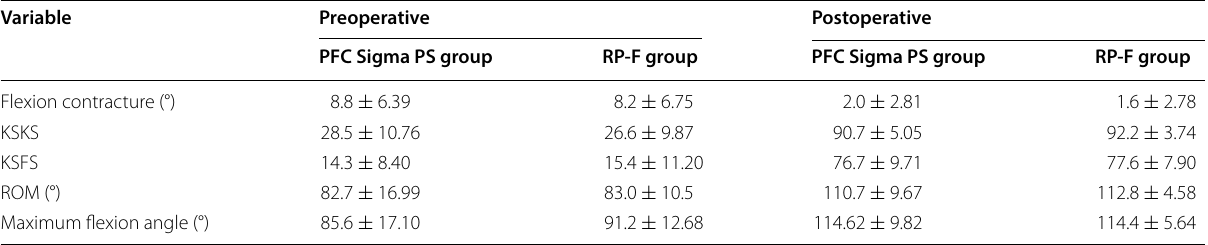
Table 2 Comparison of preoperative and postoperative variables between PFC Sigma PS group and RP-F group